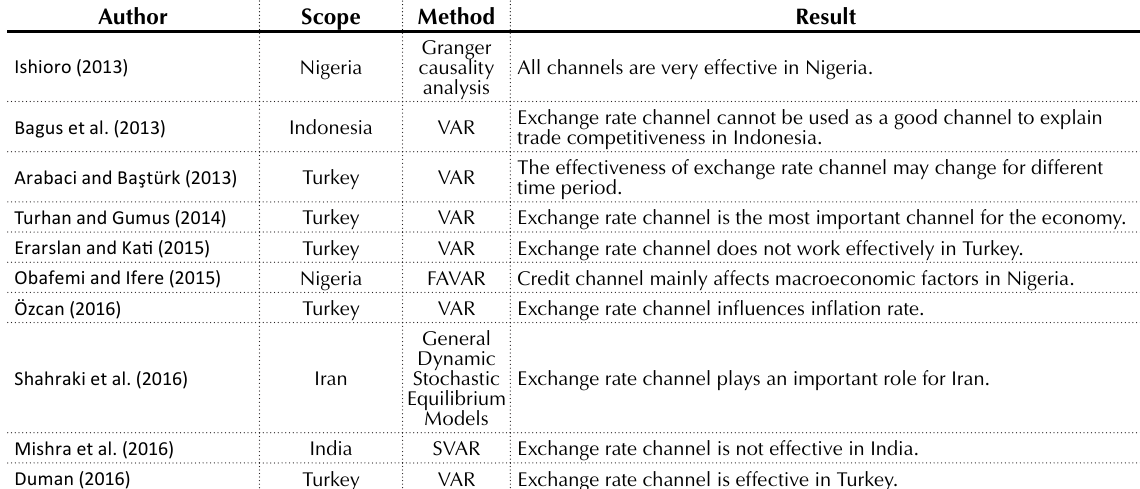
Table 1 (cont.). Selected studies for exchange rate